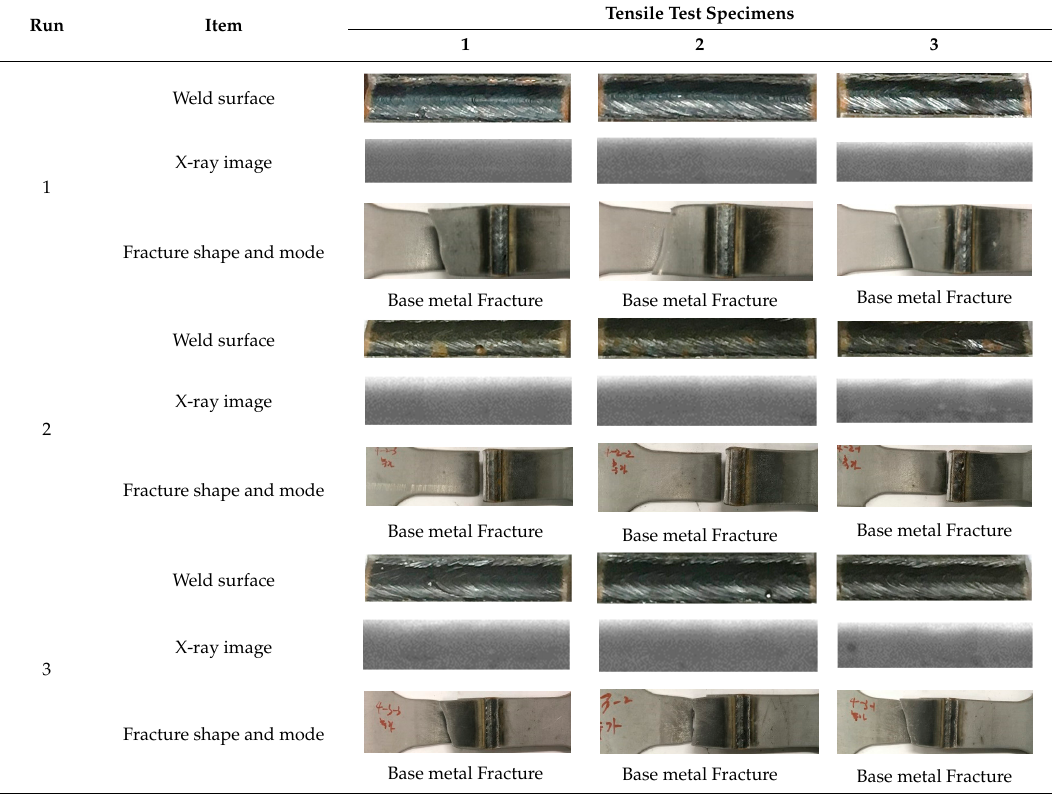
Table 7 lists the porosity and TSS values of each test specimen with no pores. The TSS of every test specimen is higher than the allowable tensile shear strength.